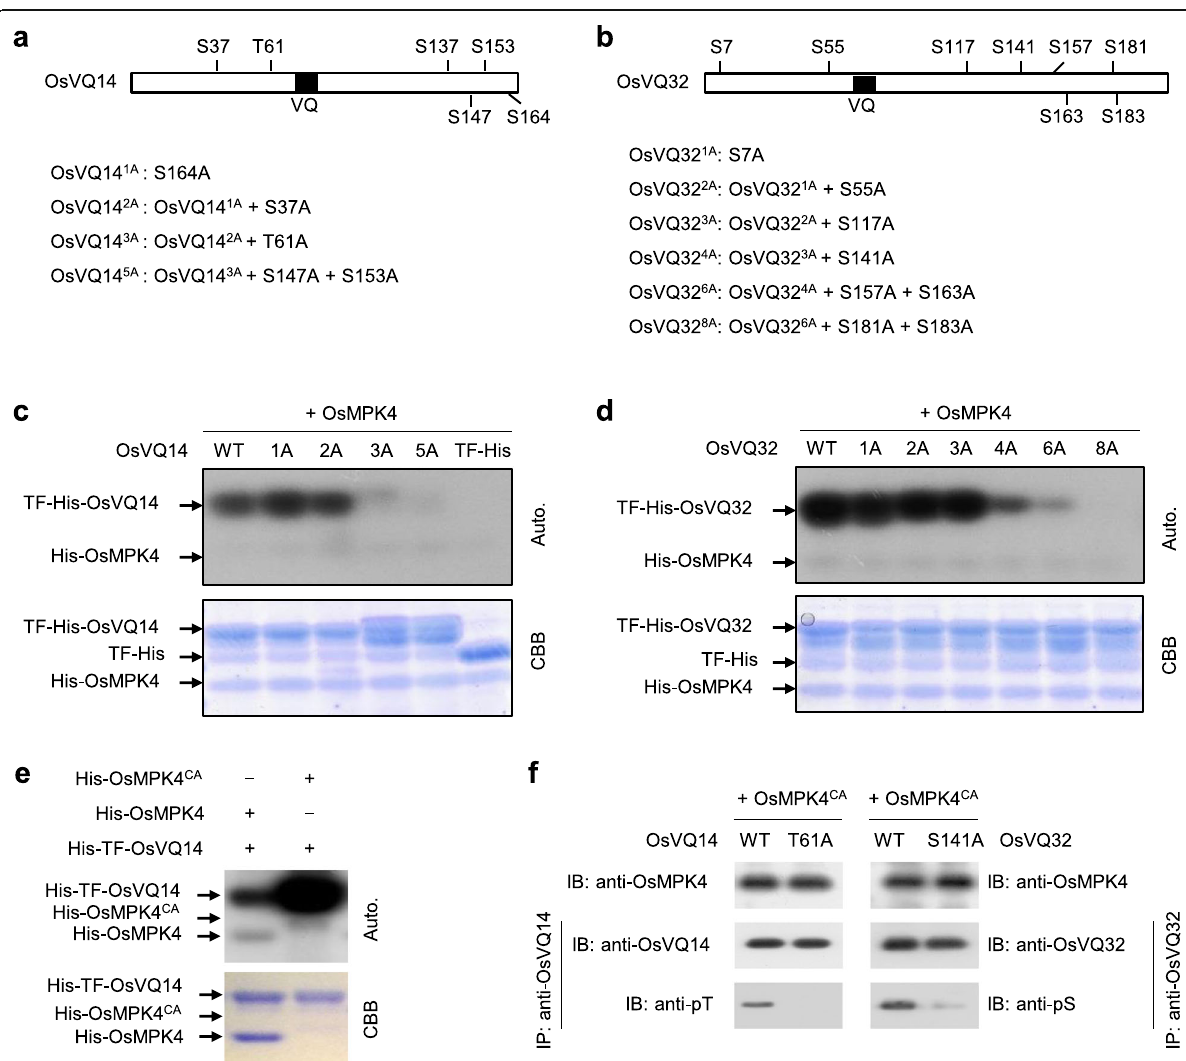
Fig. 4 OsMPK4 phosphorylated OsVQ14 and OsVQ32. a and b Mutagenesis of putative MAPK phosphorylation sites of OsVQ14 ( a ) and OsVQ32 ( b ). c and d Phosphorylation assays of wild-type (WT) and mutated OsVQ14 ( c ) and OsVQ32 ( d ) by OsMPK4 in vitro. TF-His, trigger factor (TF) and histidine (His) tag. Auto., Autoradiograph; CBB, Coomassie brilliant blue staining. e In vitro kinase activity toward OsVQ14 of OsMPK4 and its constitutively active (CA) mutant. f Phosphorylation assays of wild-type (WT) and mutated OsVQ14 and OsVQ32 by OsMPK4 CA in vivo. IP,